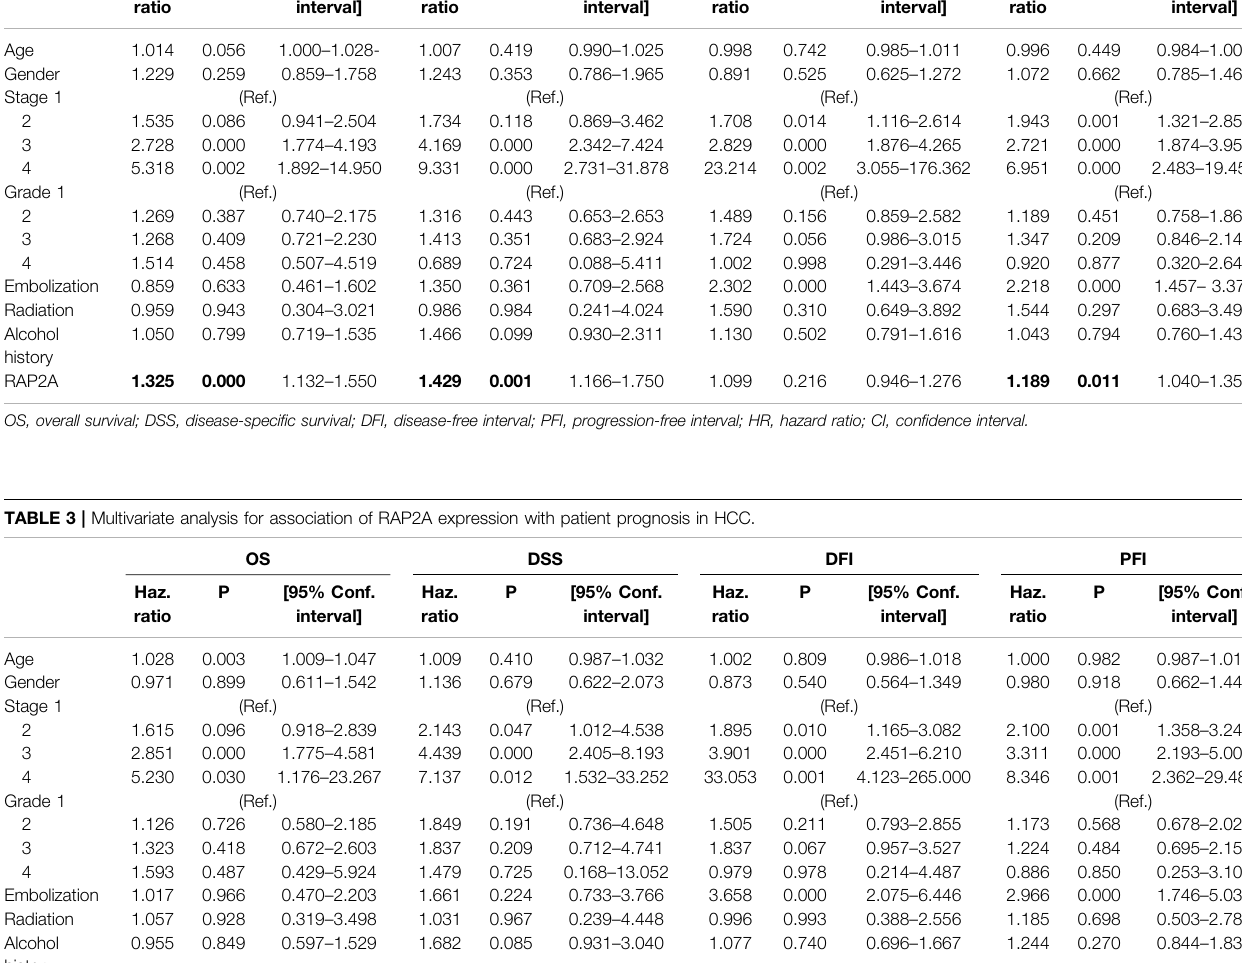
TABLE 2 | Univariate analysis for association of RAP2A expression with patient prognosis in HCC. OS DSS DFI PFI Haz. P [95% Conf. ratio interval]